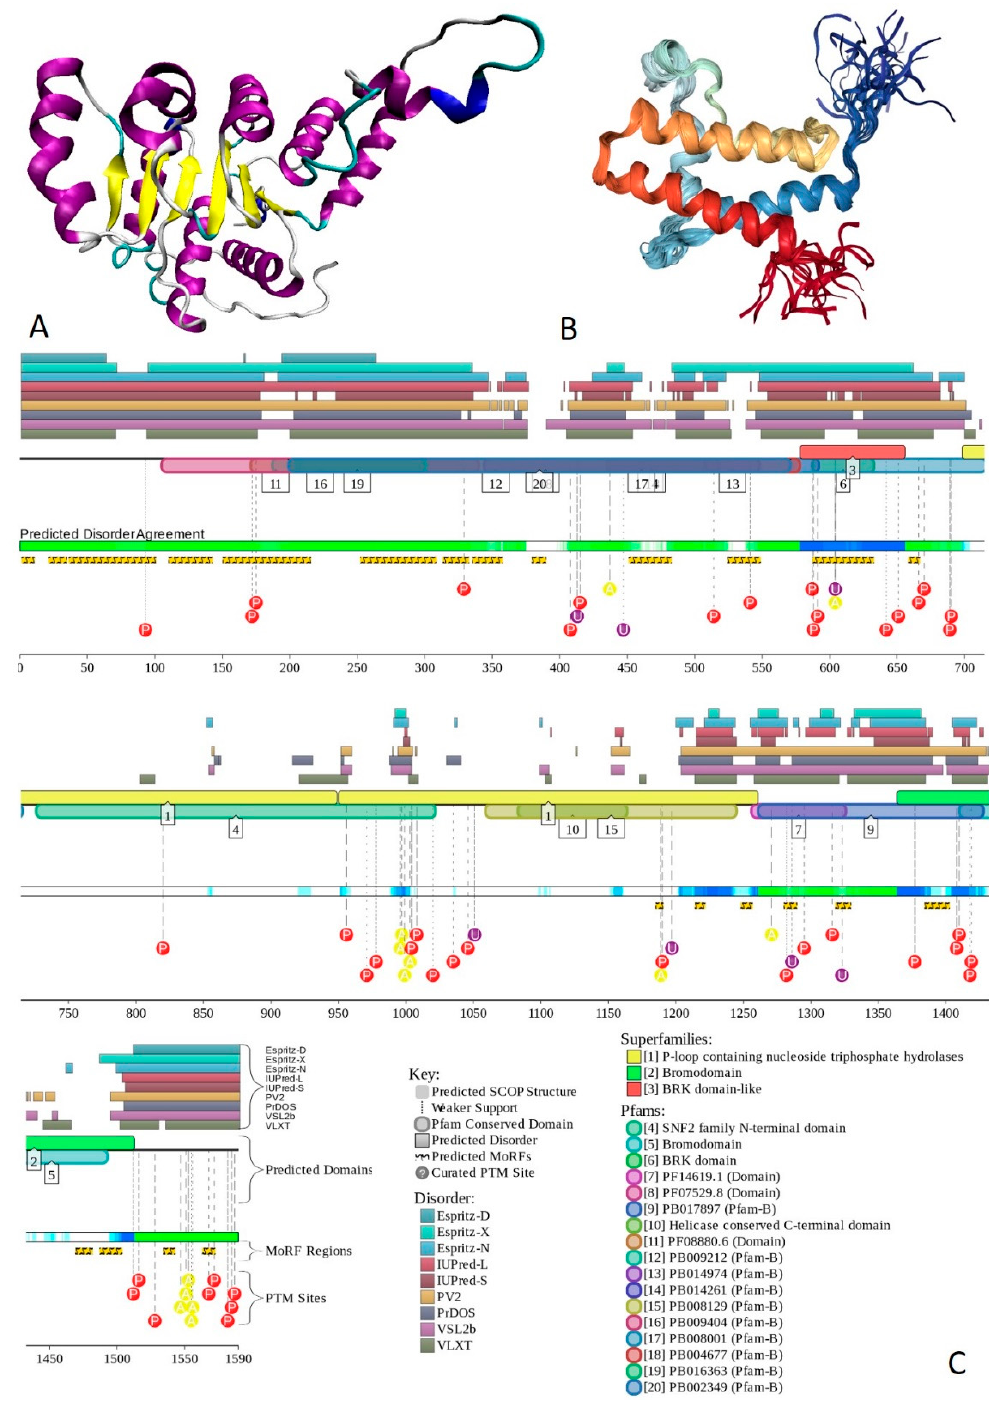
Figure 6. Structural organization of human BRM protein. ( A ) X-ray crystal structure of helicase ATP-binding domain (residues 705–955; PDB ID: 6EG3). ( B ) NMR solution structure of the bromodomain (residues 1477–1504, PDB ID: 2DAT). C . D 2 P 2 functional disorder profile of the human BRM protein (UniProt ID: P51531).